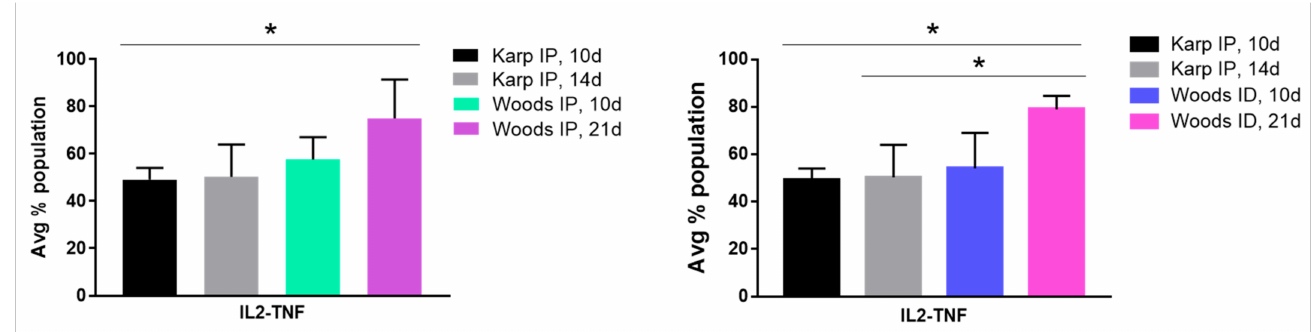
Figure 10. CD8 nonlethal (protective) cytokine signature. Significant differences in IL2-TNF cytokine populations were observed in the interstrain comparisons between the lethal and nonlethal models. A significant increase in the IL2-TNF population was observed in the nonlethal IP model at 21d compared to the lethal model at 10 dpi. A significant increase in the IL2-TNF population was observed in the nonlethal ID model at 21dpi compared to the lethal model at both 10 and 14 dpi. Significant differences between average cytokine populations in the lethal and nonlethal models are indicated by asterisks (*, p <